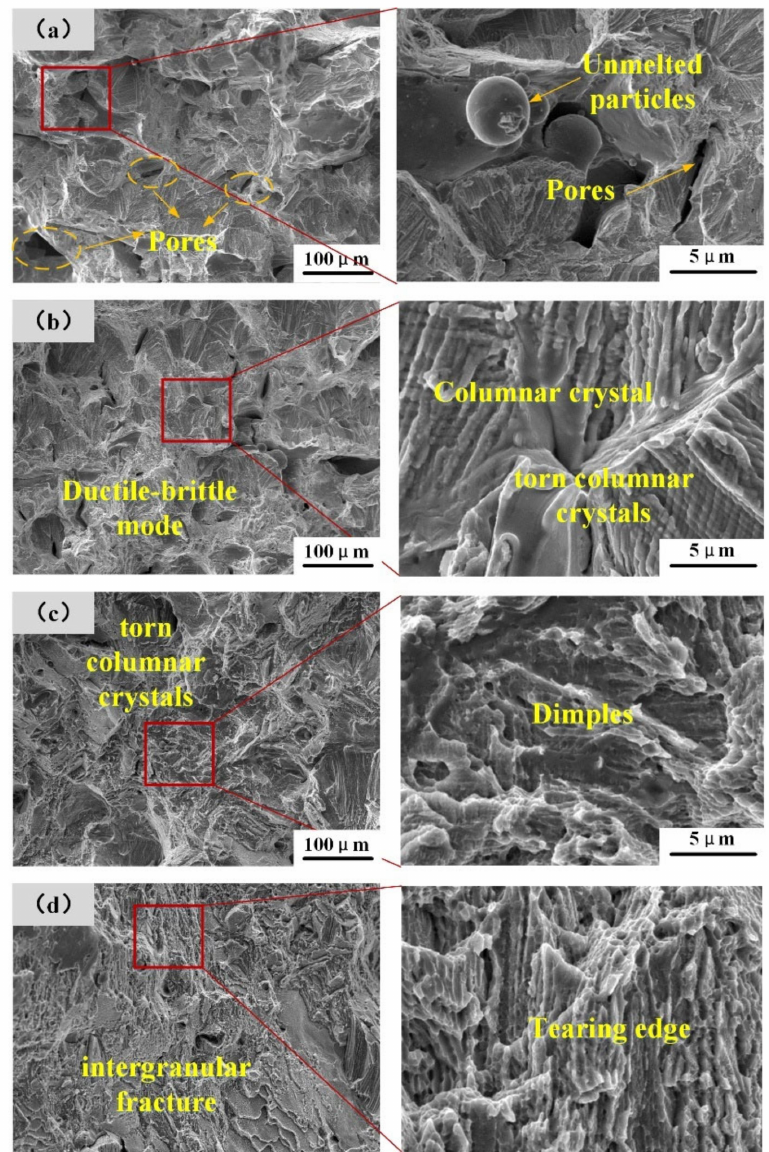
Figure 11. SEM images showing fracture surfaces for K 418 samples processed with LPBF at various energy densities VED: ( a ) 37.5 J/mm 3 ; ( b ) 62.5 J/mm 3 ; ( c ) 81.6 J/mm 3 ; ( d ) 93.7 J/mm 3